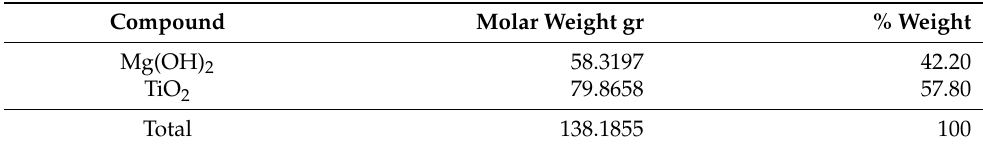
Table 2. Percentage by weight for brucite- and titania-based formulations.